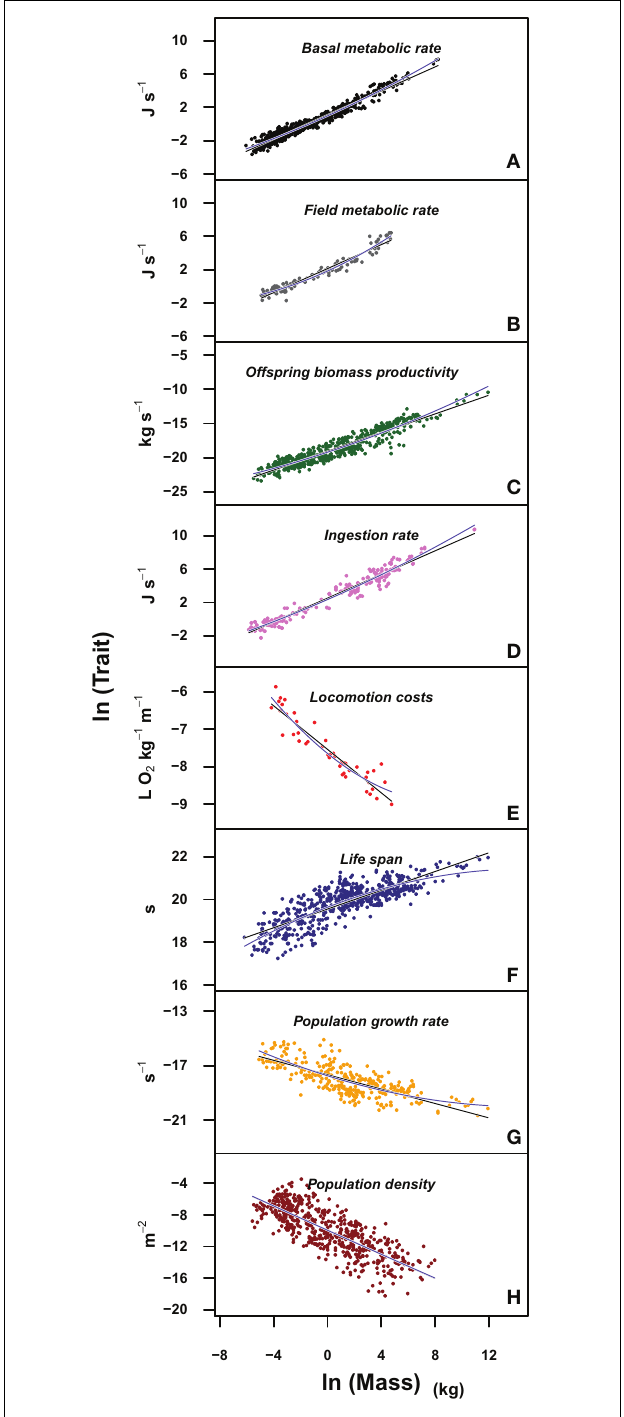
FIGURE 1 | Plots of the different life history traits (A: basal metabolic rate; B: field metabolic rate; C: offspring biomass productivity; D: ingestion rate; E: locomotion costs; F: life span; G: population growth rate; H: population density) vs. body mass in a log-log scale. Blue lines correspondtothefitofthequadraticmodelandblacklinestothefitofalinear model. The upper panels correspond to individual level traits, while the lower panels to population level traits. See Data Sheet 1 in Supplementary Material for the bibliographic sources used to construct each